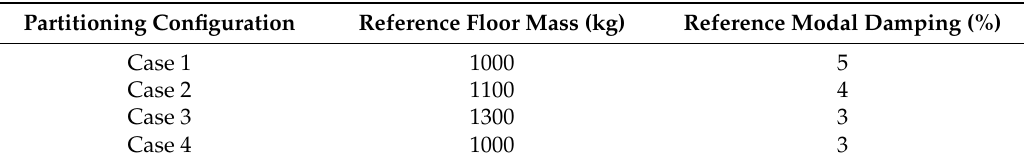
Table 1. Partitioning cases.